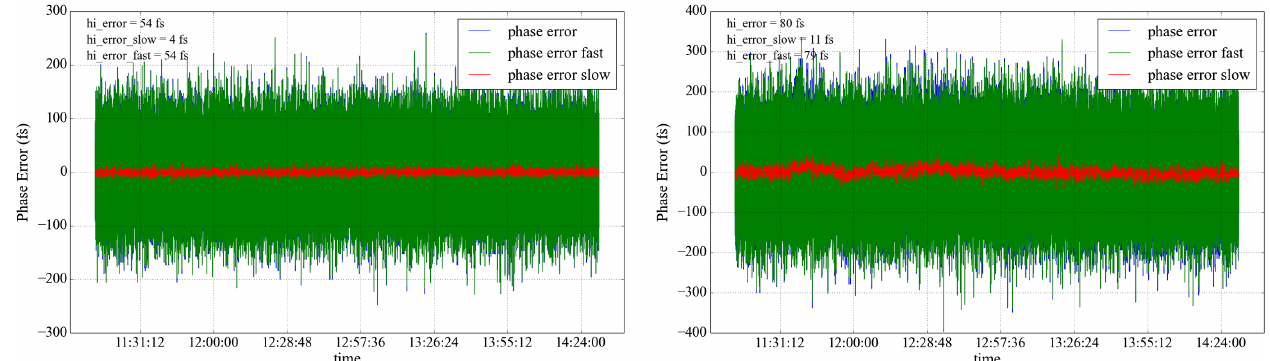
FIG. 4. The test result of the 3-hour mutual monitoring and detecting experiment: (a) the working system is running at close loop mode. (b) the monitoring system is running at open loop and detecting the phase error between the reference and driver RF from working